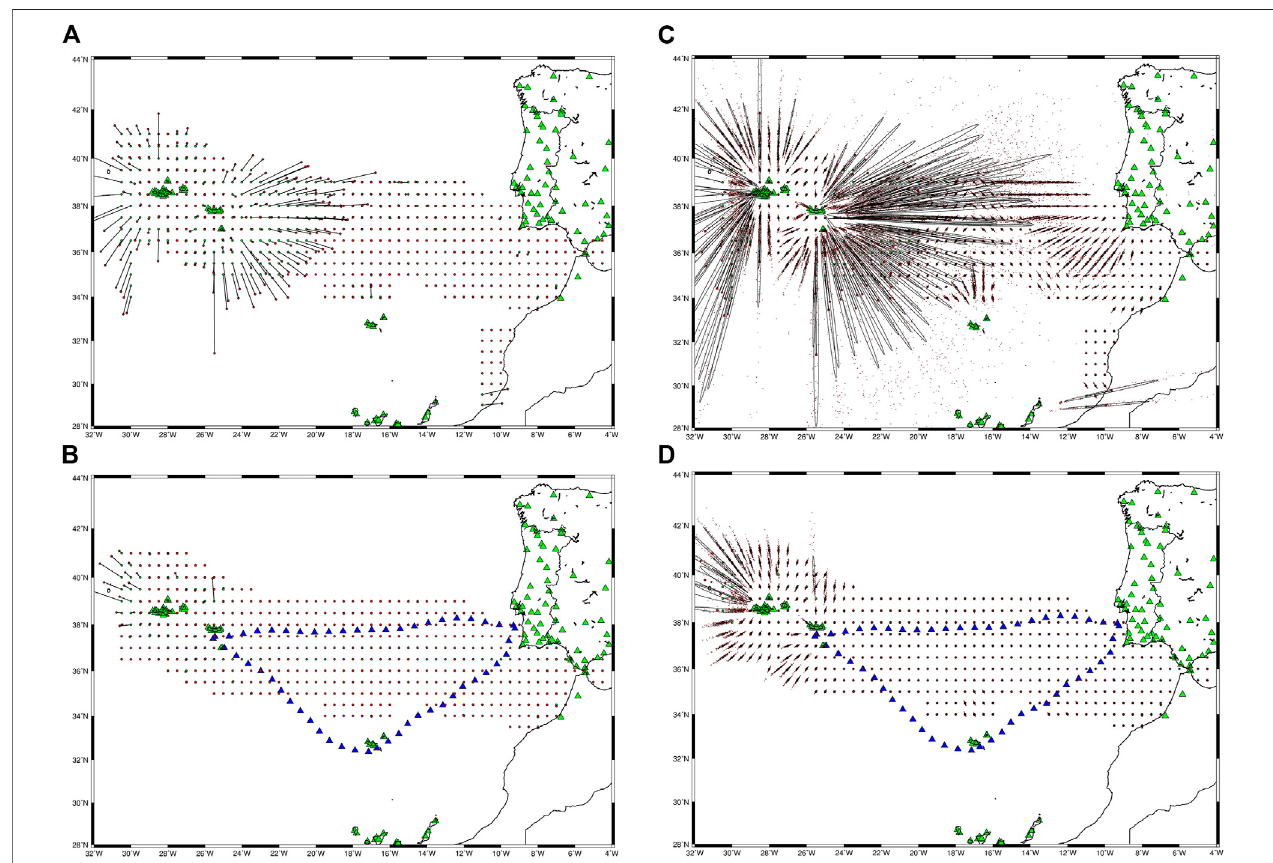
FIGURE 7 | Visual comparison of Monte-Carlo quality earthquake location parameters when the synthetic catalogue is analyzed by the land only seismic station network(LAND,greentriangles)oranalyzedbythelandandcabled(CABLE,bluetriangles). (A) DistancebetweentheMCcentroid(inred)andthetruelocation(ingreen) for LAND. (B) Distance between the MC centroid (in red) and the true location (in green) for CABLE. (C) All MC epicenters computed, and the uncertainty ellipse computed from the covariance ofthe horizontal coordinates for LAND. (D) All MCepicenters computed, and the uncertainty ellipse computed from thecovariance of the horizontal coordinates for